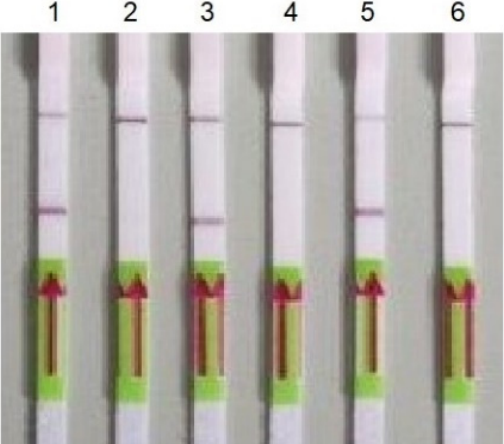
Figure 2. Detection of PCR products using LFA. 1—gene RdRP (primers nCoV_IP4-14059Fw/Rv); 2—negative control for gene RdRP; 3—gene E (primers E_Sarbeco_F/); 4—negative control for gene E; 5—gene N (primers 2019-nCoV_N2-F/R); and 6—negative control for gene E.